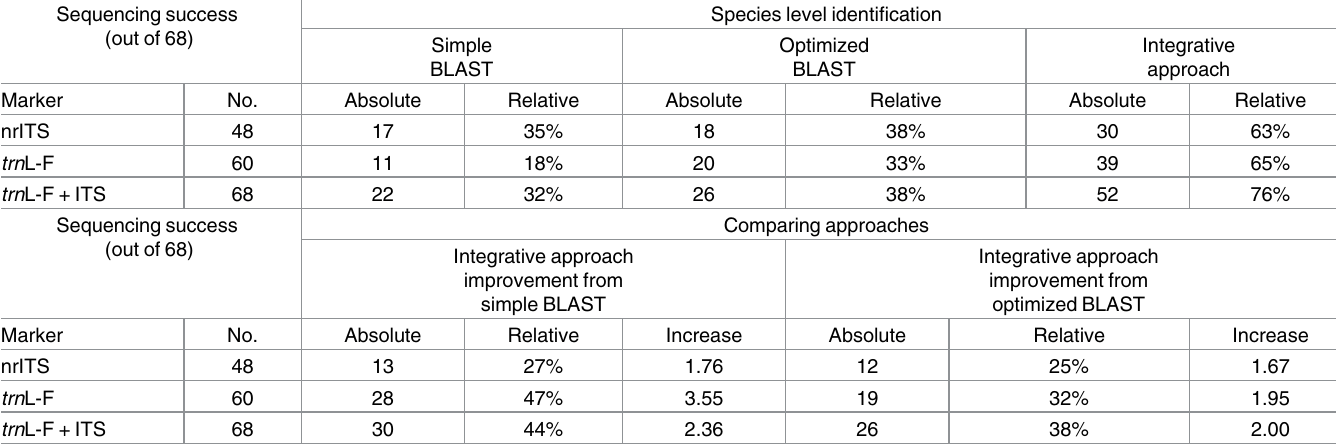
Table 1. Comparison of species level identification rates for optimized BLAST similarity-based and those using the outlined integrative approach. Sequencing success (out of